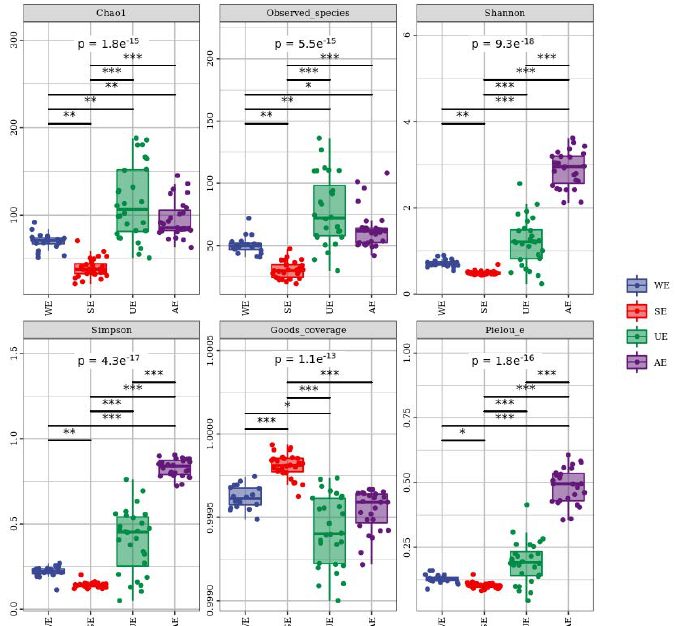
Figure 3. Seasonal di ff erence based on the Alpha index. ”WE” represents winter eDNA; ”SE” is spring eDNA; ”UE” is summer eDNA; ”AE” is autumn eDNA;”*” represents p < 0.05; “**” is p < 0.01 and “***”is p < 0.001. Each panel corresponds to an alpha diversity index, identified by the gray area at the top. In each Panel, the abscissa is the grouping label, and the ordinate is the value of the corresponding alpha diversity index; the four colors represent four reasons. The number under the label of diversity index is the p value of the Kruskal–Wallis test.